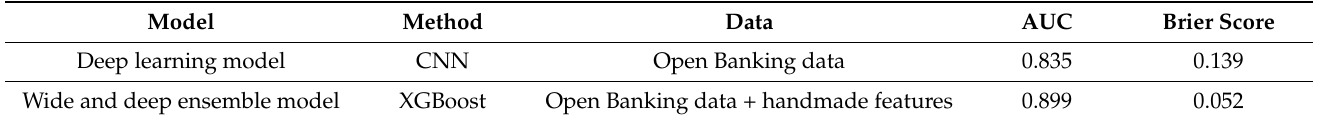
Table 4. Model performance, deep learning models, small test data set, 841 obs. (2018–2019).